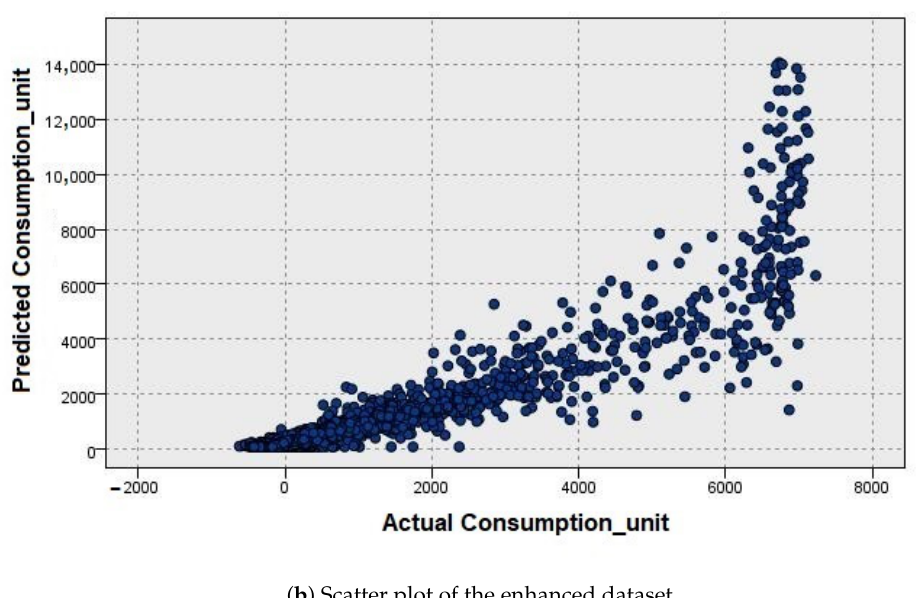
Figure 12. Scatter plots showing the relationship between the actual and predicted power consump- tion values using MLR.